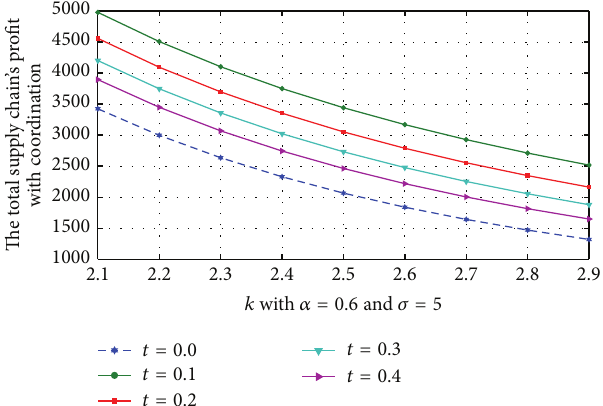
Figure 4: Impact of changes of 𝑘 on the total supply chain’s profit with coordination in different 𝑡